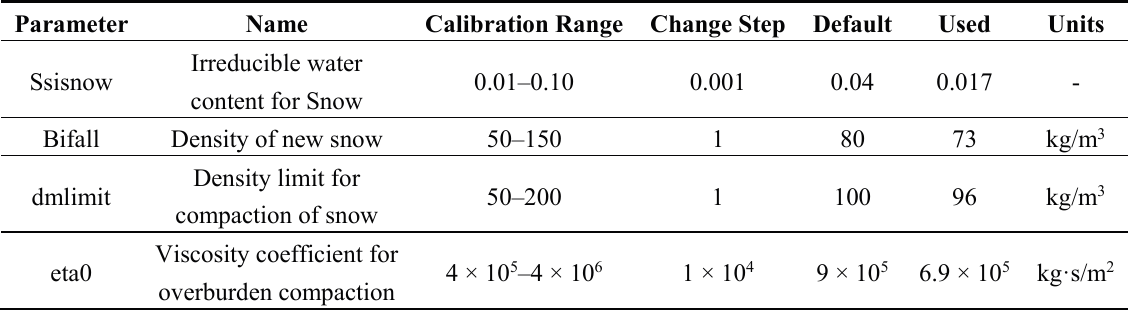
Table 2. Model parameters description, calibration range, change step for calibration, and parameter value after